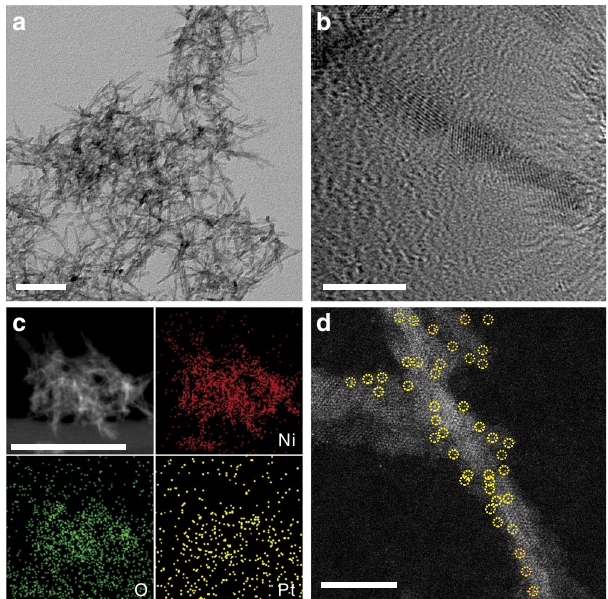
Fig. 1 Characterization of Ni(OH) x NBs and the Pt 1 /Ni(OH) x catalyst. a TEM image of Ni(OH) x NBs. Scale bar, 50 nm. b HR-TEM image of a Ni (OH) x nanoboard. Scale bar, 20 nm. c EDX elemental mapping analysis of the Pt 1 /Ni(OH) x catalyst. Scale bar, 100 nm. d Representative AC HAADF- STEM image of the Pt 1 /Ni(OH) x catalyst. The yellow circles were drawn around SAS Pt. Scale bar, 10